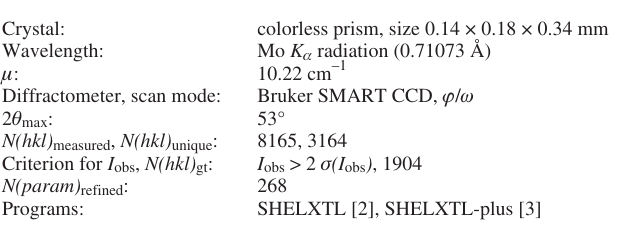
Table 1. Data collection and